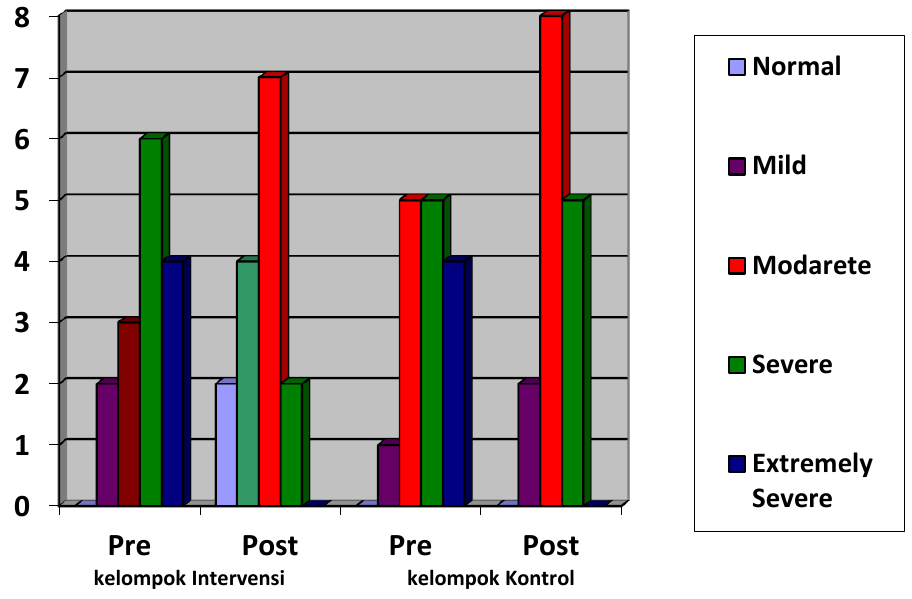
Figure 2. Pre-Post Anxiety Level Data Histogram Between the Control Group and Intervention